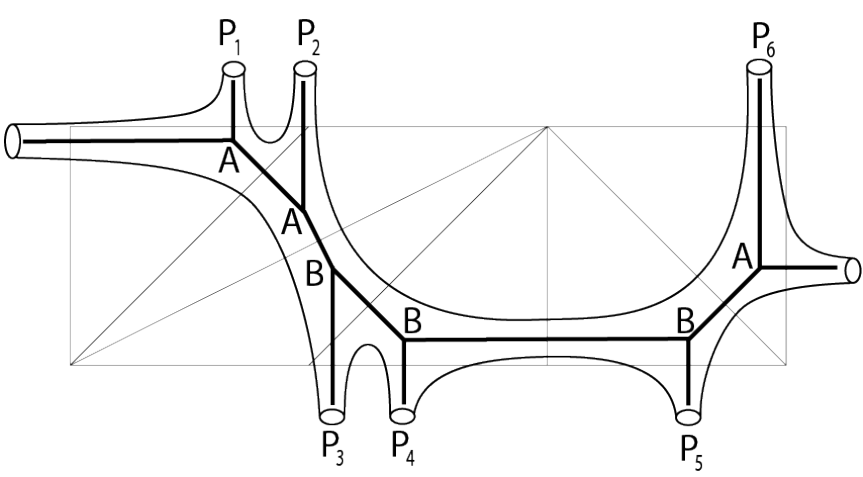
Figure 1 . An example of a strip geometry. The toric diagram (made of thick segments) arises as the dual diagram to a triangulation of a rectangular strip (made of thin segments). Trivalent vertices in this case are respectively of type A, A, B, B, B, and A, and P 1 ’s are represented by internal legs of type ( (cid:0) 2 ; 0) ; ( (cid:0) 1 ; (cid:0) 1) ; ( (cid:0) 2 ; 0) ; ( (cid:0) 2 ; 0) ; ( (cid:0) 1 ; (cid:0) 1) (from left to right). Brane boundary conditions encoded in Young diagrams P i can be imposed at one external leg of each vertex. Thickening the toric diagram leads to a schematic picture of the mirror curve (shown in thin